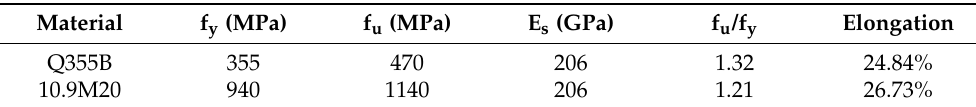
Table 3. Material properties of